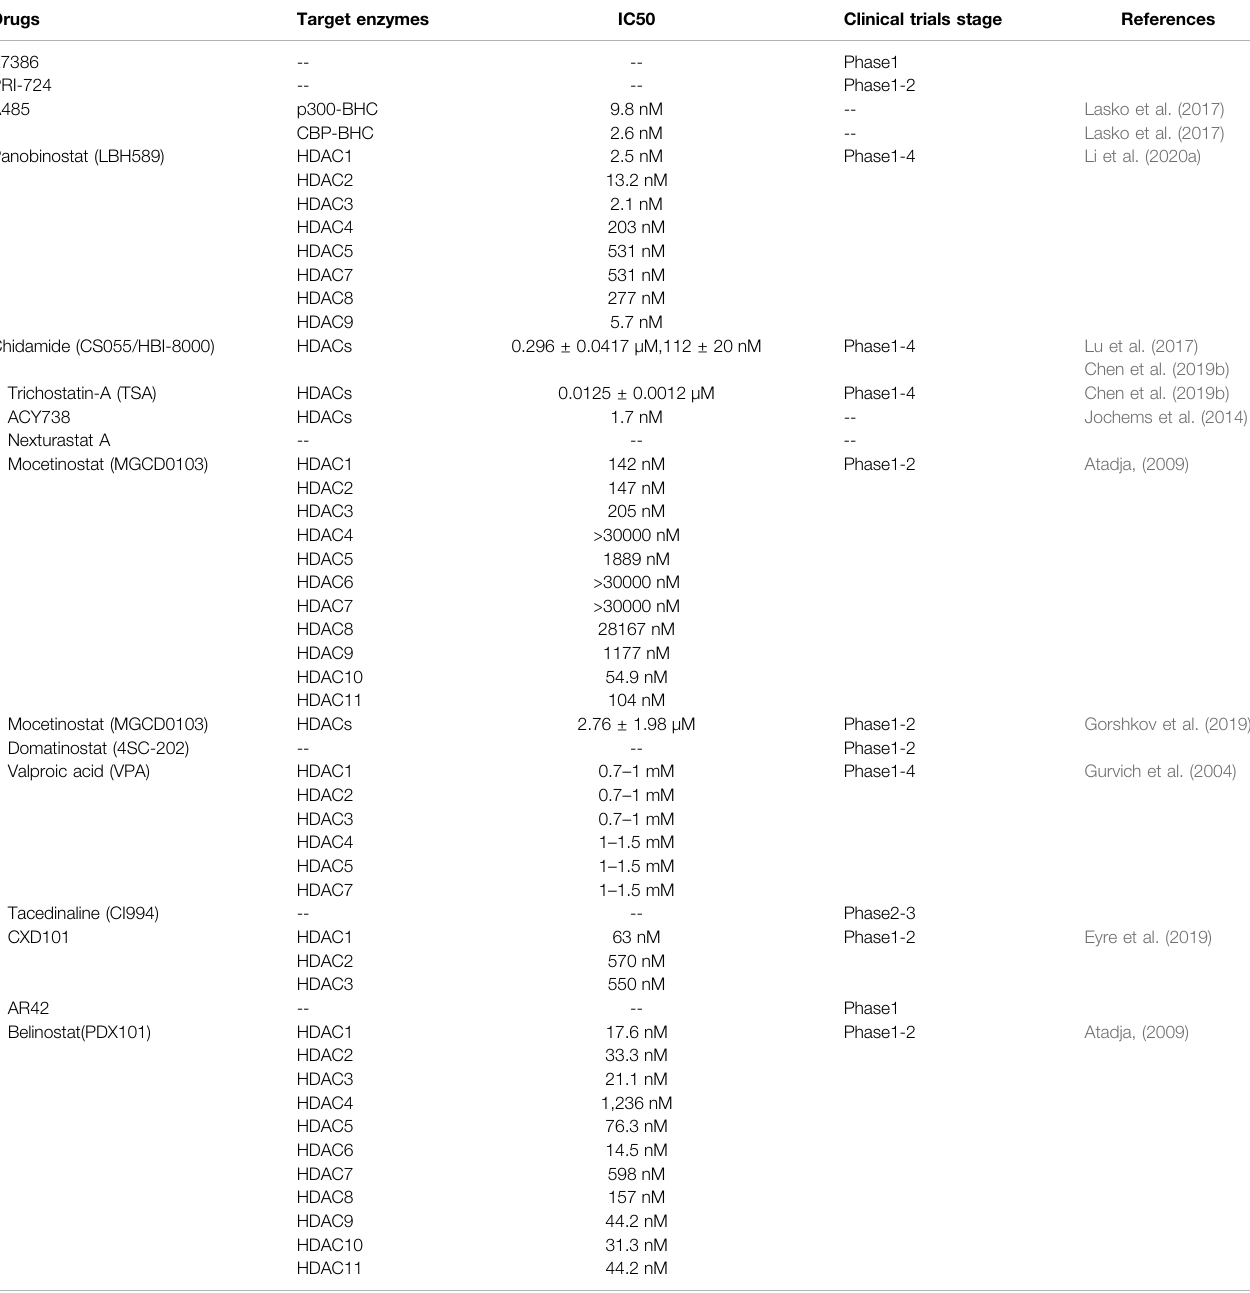
TABLE 3 | Information of drugs targeted to acetylase and